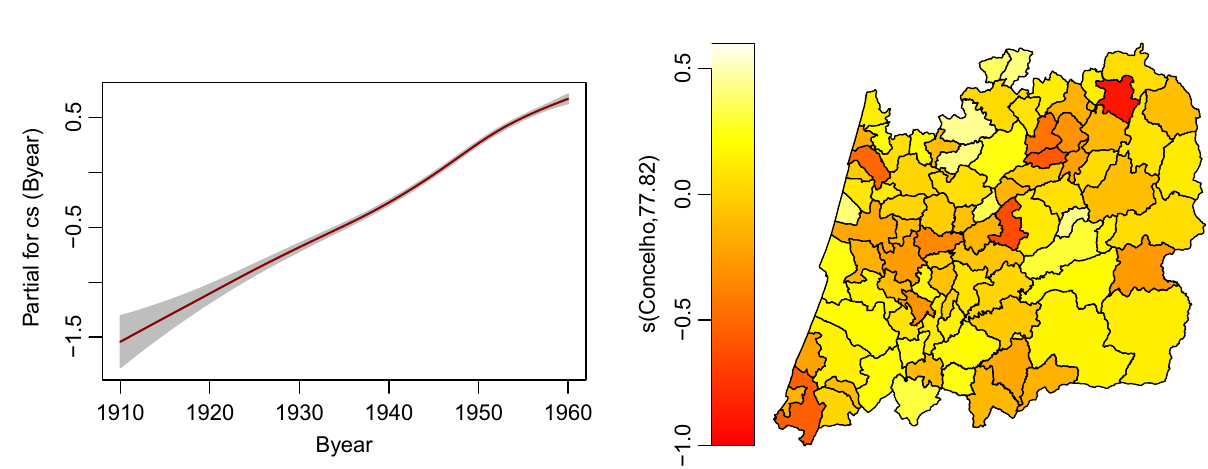
Figure 4. Estimated AaM by region and birth year. Percentiles 5%, 50% and 95% for the central region of Portugal for the years 1940, 1950 and 1960. The highlighted area for the year 1950 represents the municipality of Oleiros.